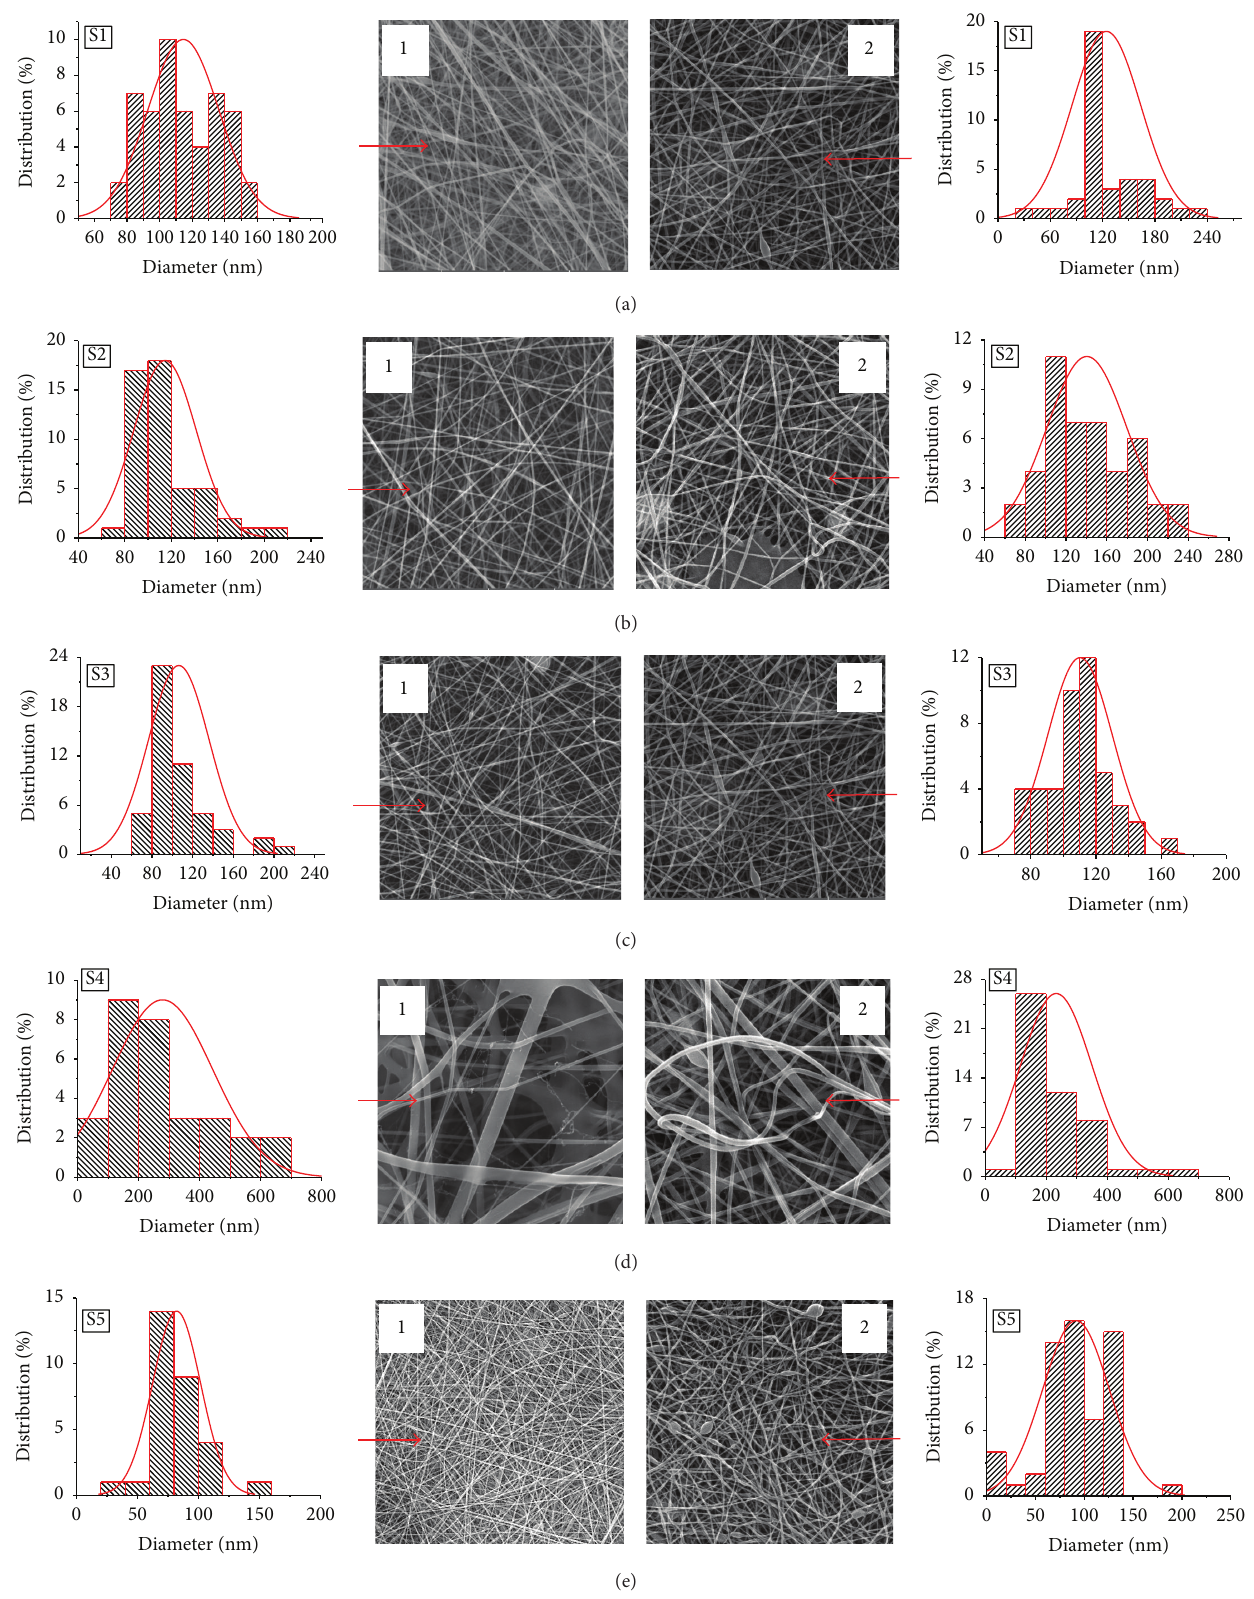
Figure 3: SEM images and fibre diameter distribution of samples (a) S1, (b) S2, (c) S3, (d) S4, and (e) S5 before (1) and after (2) the lamination